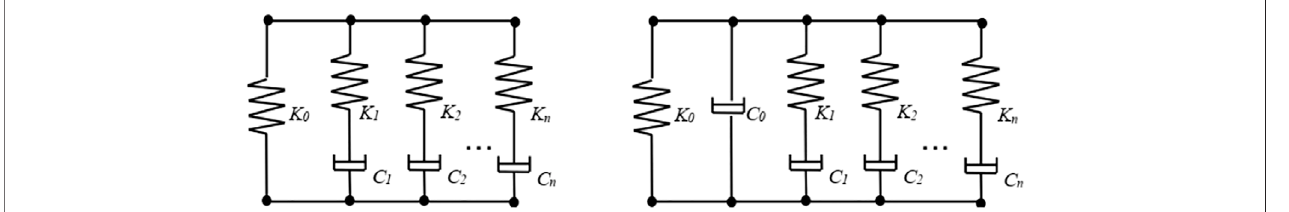
FIGURE 3 | Examples of the generalized Maxwell